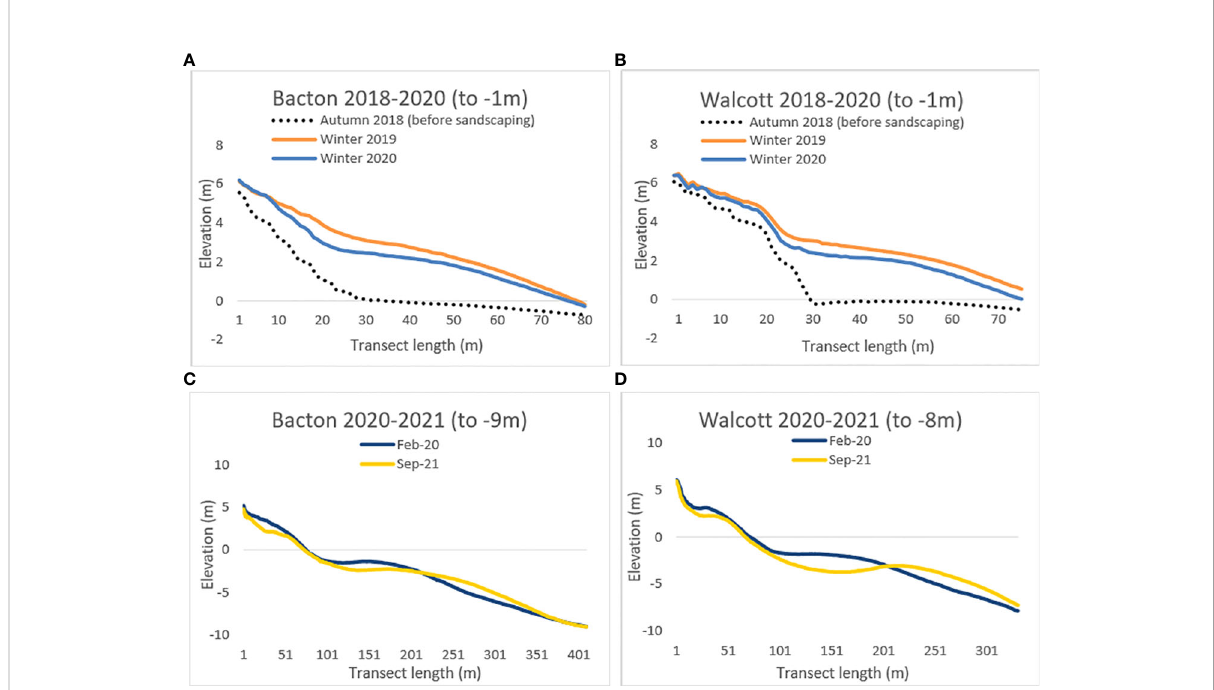
FIGURE 2 Beach pro fi le elevation changes at Bacton (panel (A) ) and Walcott (panel (B) ) from 2018-2020, comparing changes on the upper shore and foreshore (to a depth of approximately -1m) before (dotted black line) and after sandscaping (year 1 in orange, year 2 in blue). Panel (C) and panel (D) reveal beach pro fi le elevation changes at Bacton (panel (C) ) and Walcott (panel (D) ) for the timeseries 2020-2021, which corresponds to the two years after implementation of the scheme. Panel (C) and panel (D) sample to a depth of approximately -9m, revealing changes in the sub-tidal zone. Transects begin at the sea wall at Bacton and Walcott, and transect length increases seaward, as plotted on the x-axis. Panel (A) and panel (B) show secondary data from the Anglian Coastal Monitoring Programme (2022); panel (C) and panel (D) are secondary data from Royal Haskoning DHV